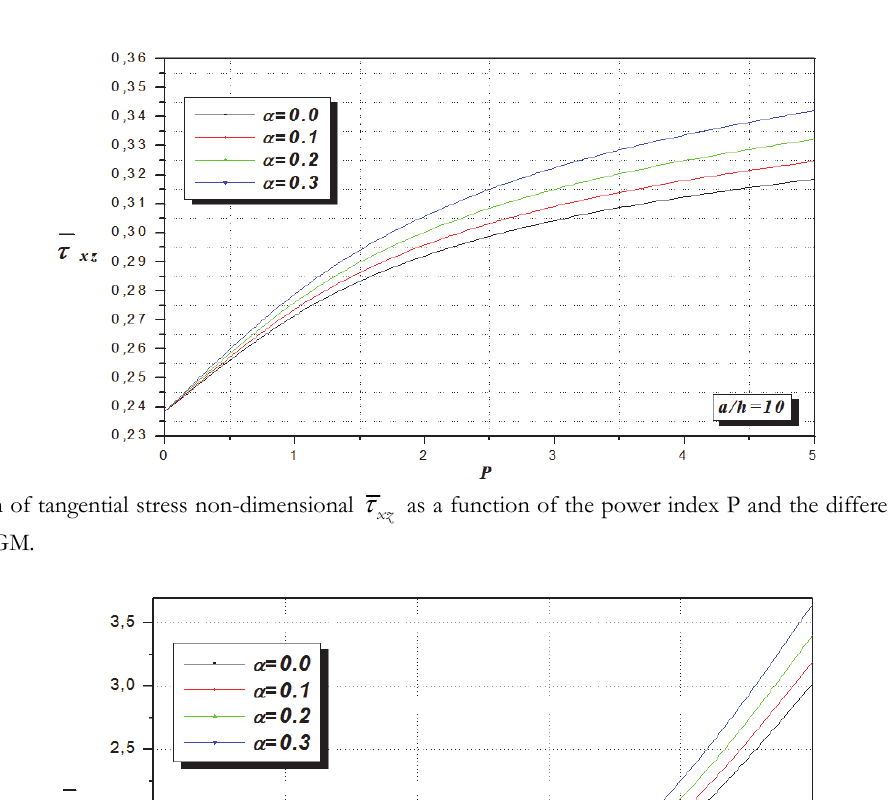
Figure 11: Variation of tangential stress non-dimensional of sandwich plate